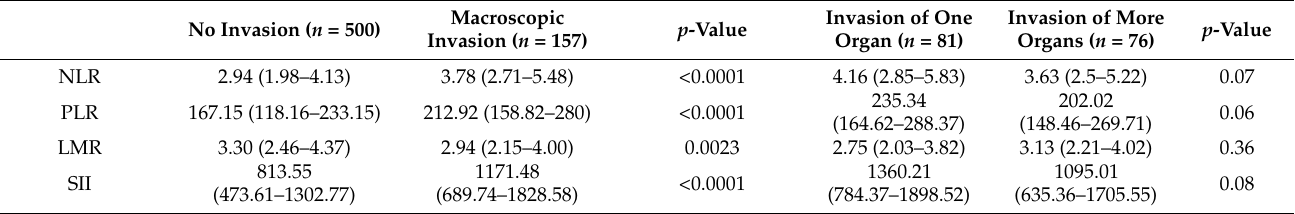
Table 5. Inflammatory biomarkers at presentation regarding macroscopic invasion ( n = 657).